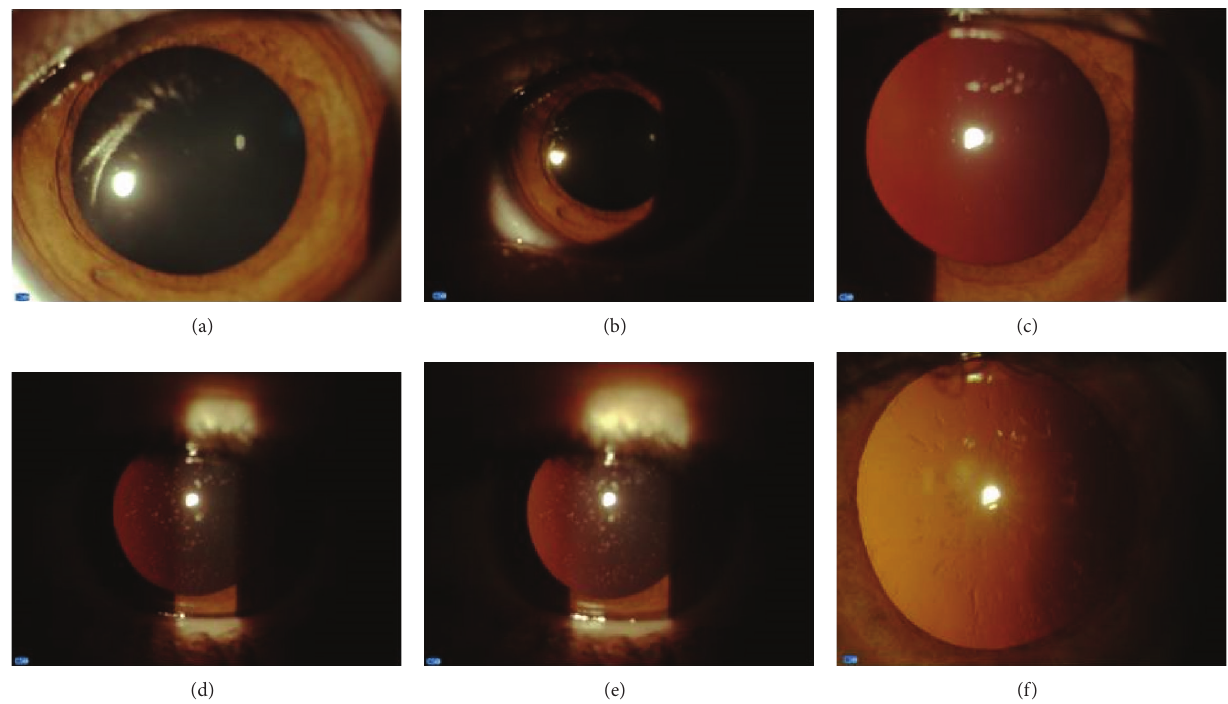
Figure 3: Progression of cataract in the left eye of the patient described in the second case report, from 2008 (a) to 2010 (b) to 2011 (c); bilateral cataract in the 14-year-old sister of the second case report: (d) right eye; (e) left eye. Cataract in the mother’s eye of the second case report